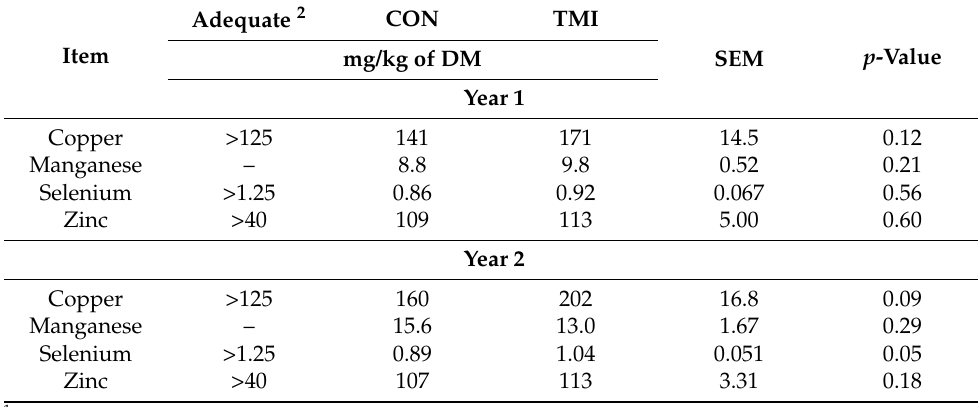
Table 5. Effect of trace mineral injection (TMI) 1 on liver trace mineral concentrations of calves at weaning (~195 days of